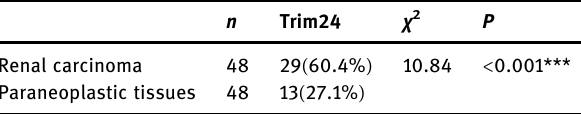
Table 3: The relationship between Trim24 expression and patho - logical